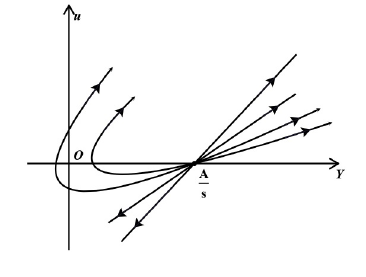
Fig. 4 Differential equation model of economic adjustment under unstable nodes